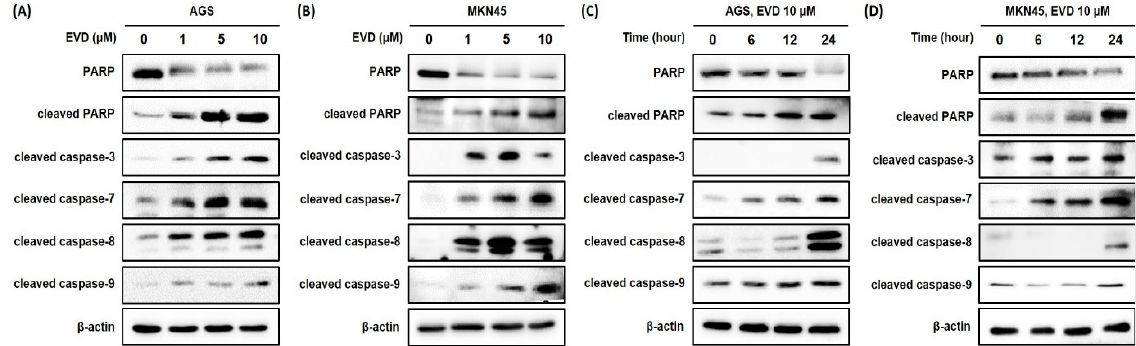
Figure 3. Evodiamine stimulates induction of PARP cleavage and the cleavage of caspase-3 and caspase-7 in AGS and MKN45 cell. Indicated doses of evodiamine (0, 1, 5 and 10 μ M) for 24 h were applied to ( A ) AGS and ( B ) MKN45 cells. A total of 10 μ M evodiamine for the indicated time periods (0, 6, 12, and 24 h) was applied to ( C ) AGS and ( D ) MKN45 cells. The cell lysates were subjected to Western blot to evaluate the levels of PARP, cleaved PARP, and cleaved caspase-3, -7, -8, and -9. β -actin was used as an internal control. EVD, evodiamine.